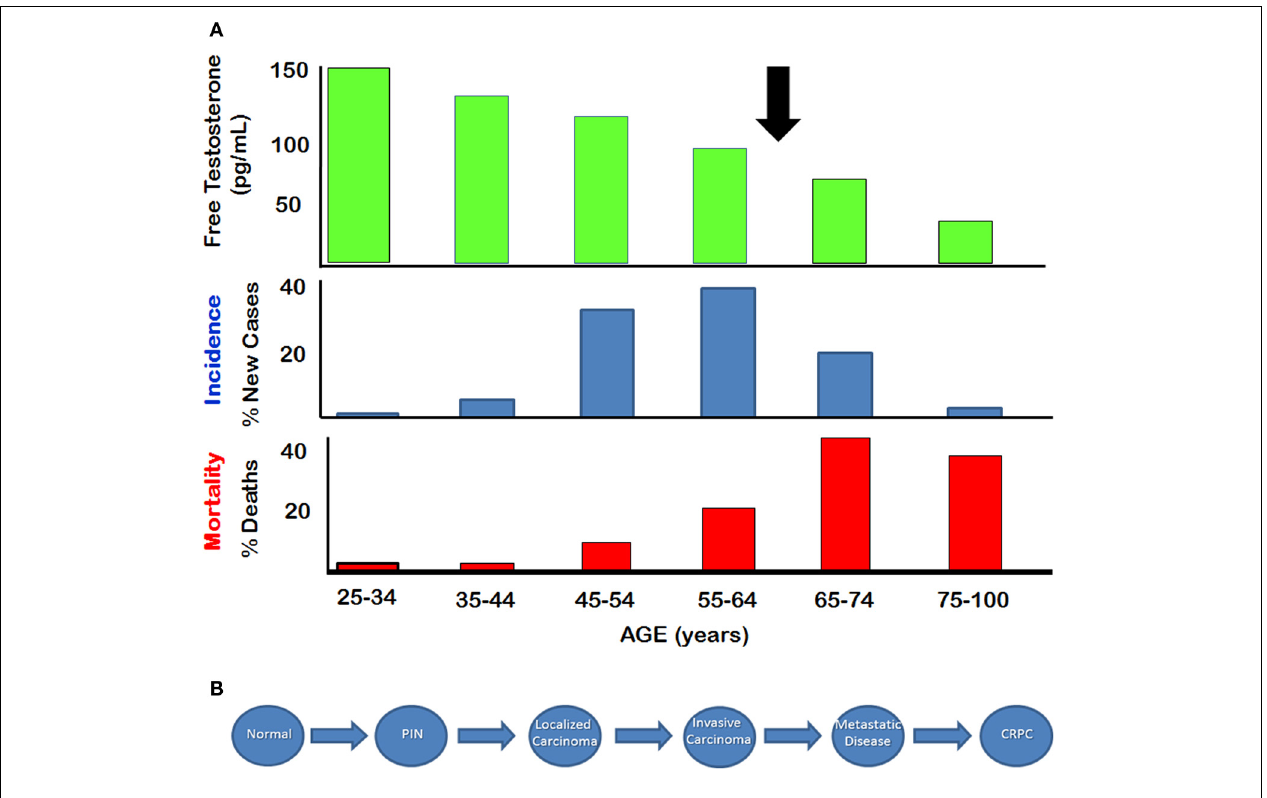
FIGURE 1 | Natural History of Prostate Cancer (A) Relationship between serum free testosterone and incidence and mortality of prostate cancer. Arrow indicates approximate age at which free testosterone declines below 50% of the level seen in young adults.